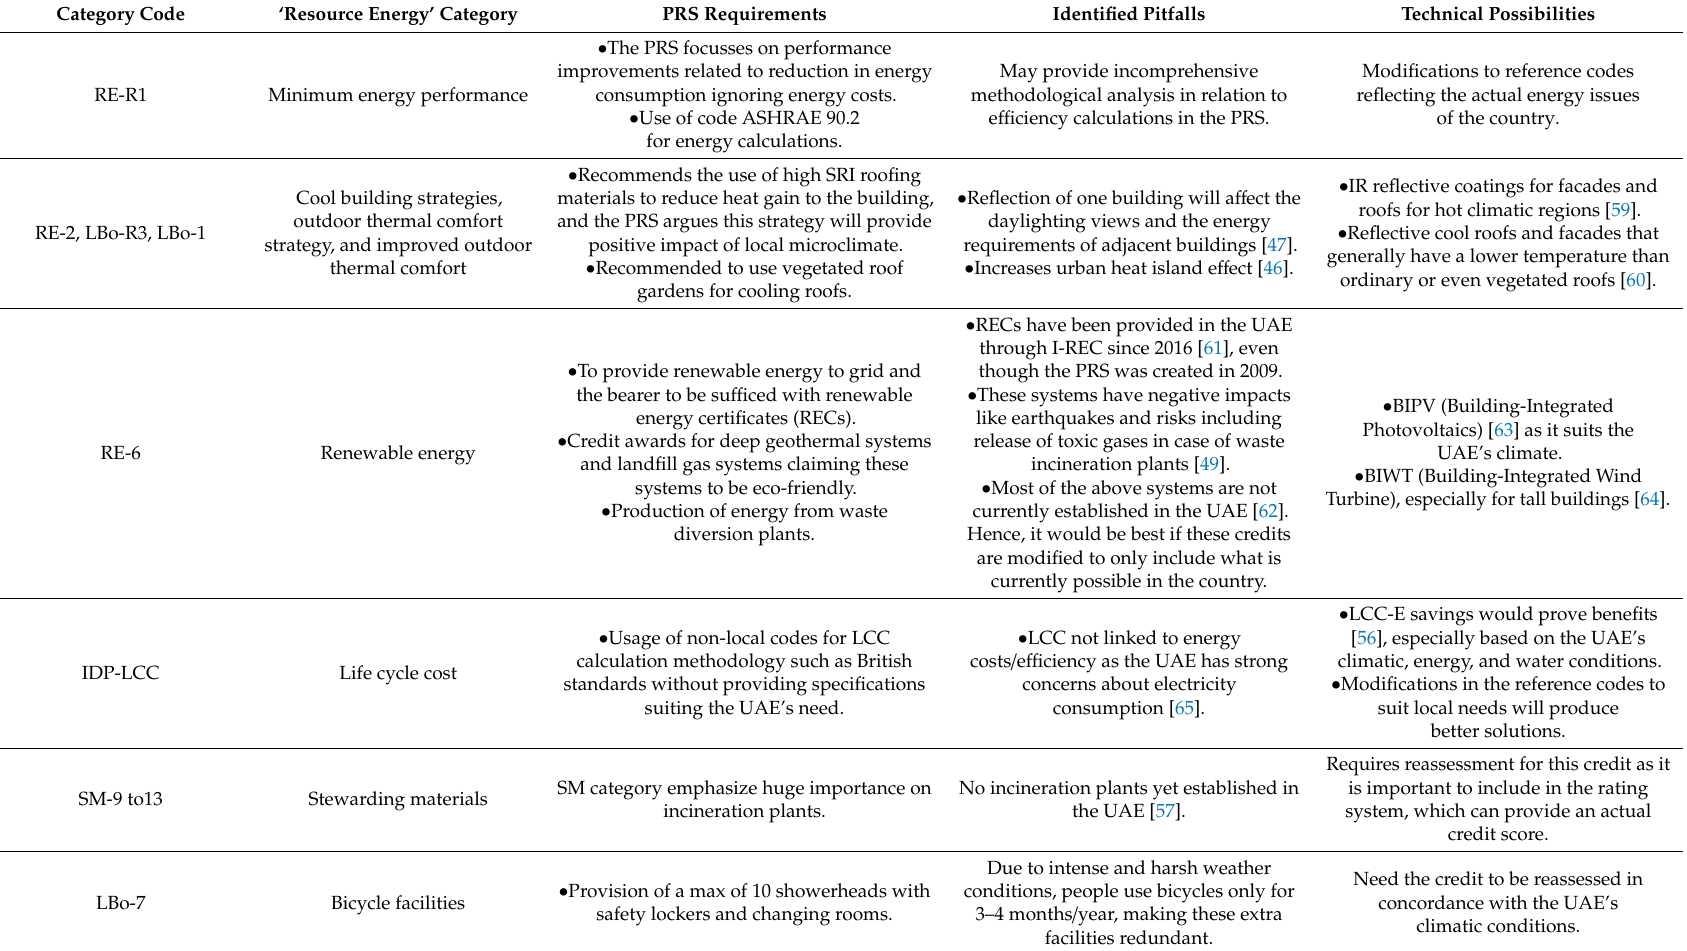
Table 2. Summary of the energy category of the Pearl Rating System with identified problems from the nexus perspective. ( RE : Resourceful Energy , IDP : Integrated Development Process ; SM : Stewarding Materials ; LB : Livable Buildings